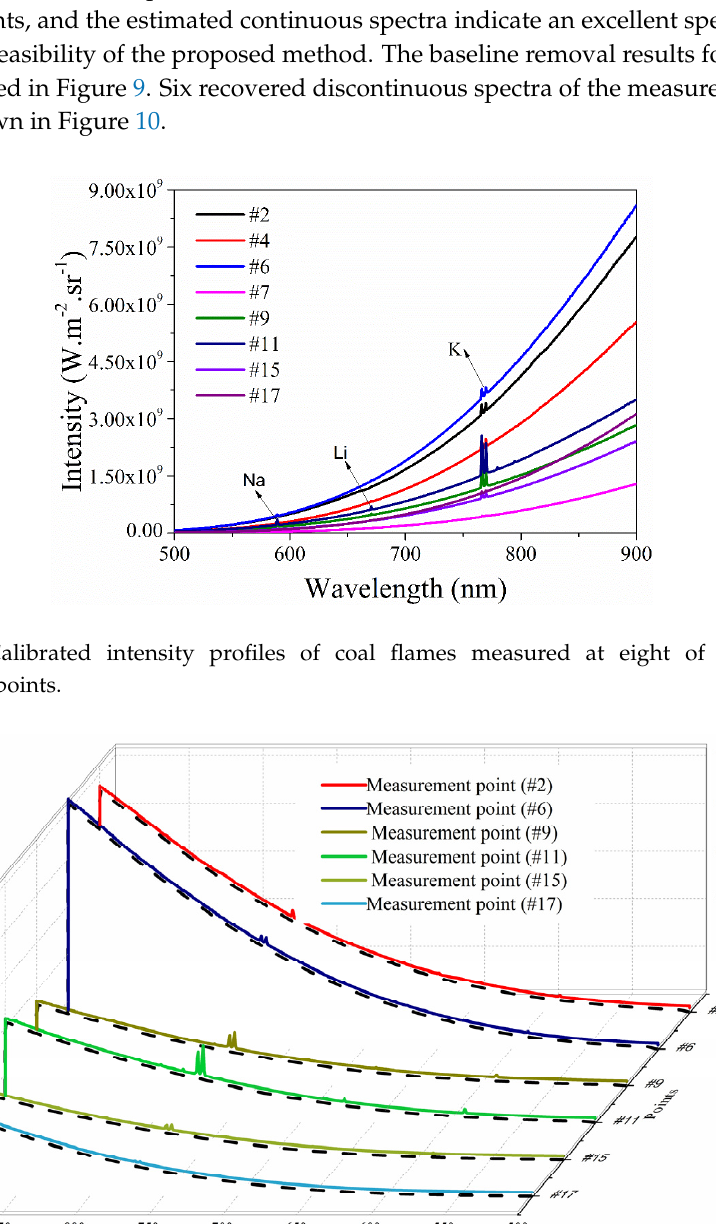
Figure 9. Baseline removal results for six observation points.